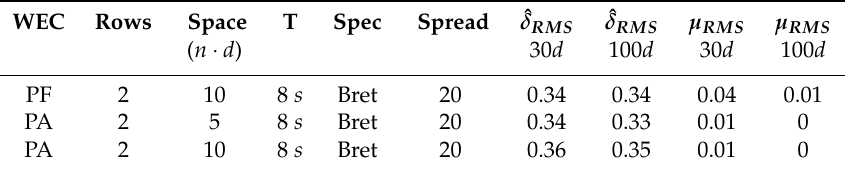
Table 6. WEC array results with the normalized RMS difference, ˆ δ RMS , and RMS wave field disturbance, µ RMS